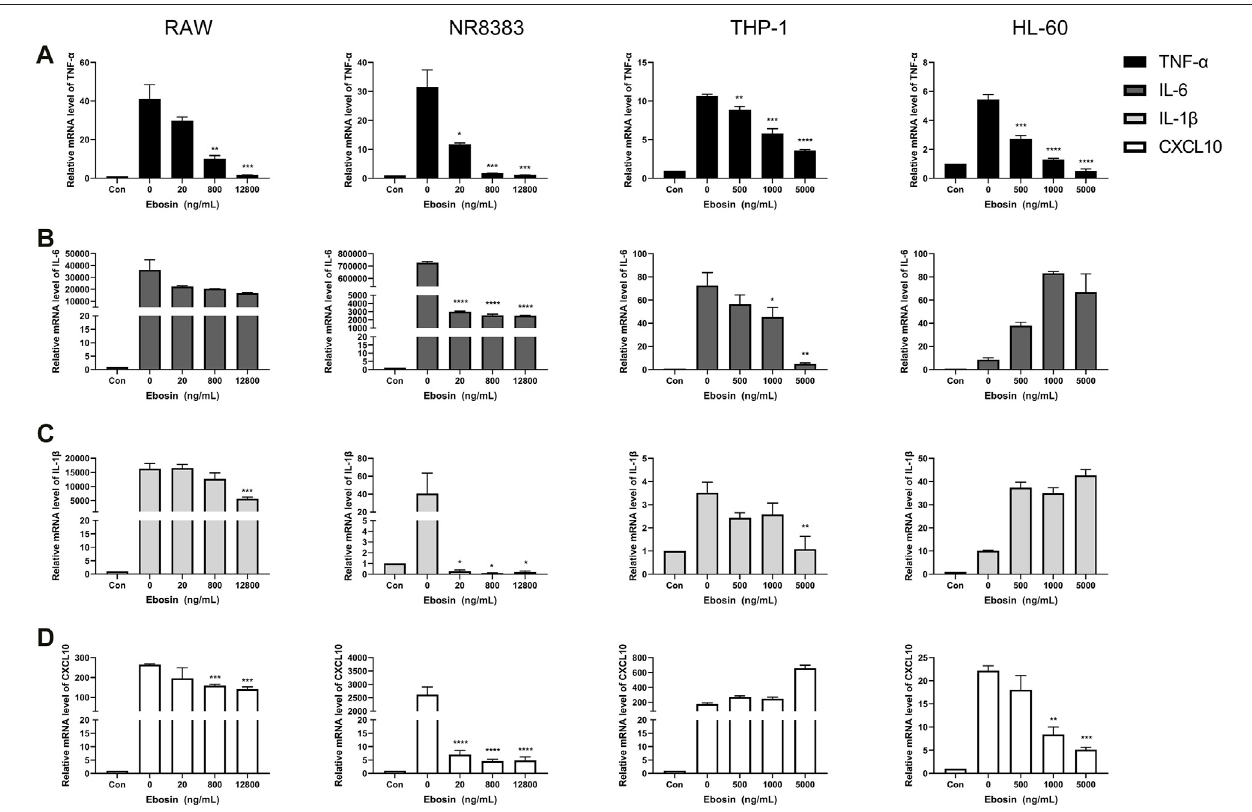
FIGURE 4 | Ebosin inhibits the expression of TNF- α , IL-6, IL-1 β , and CXCL10 in macrophages. RT-PCR quantitation of TNF- α (A) , IL-6 (B) , IL-1 β (C) and CXCL10 (D) mRNAexpressioninRAWandNR8383cellsstimulatedwithLPS(100 ng/ml)followingtreatmentwith20,800,and12,800 ng/mlEbosin,andinTHP-1and HL-60cells stimulated withLPS (100 ng/ml)followingtreatmentwith500, 1,000, and 5,000 ng/ml Ebosin. (mean ± SD, n (cid:1) 3) * p < 0.05, ** p < 0.01, *** p < 0.001,**** p < 0.0001 vs. LPS-induced group.